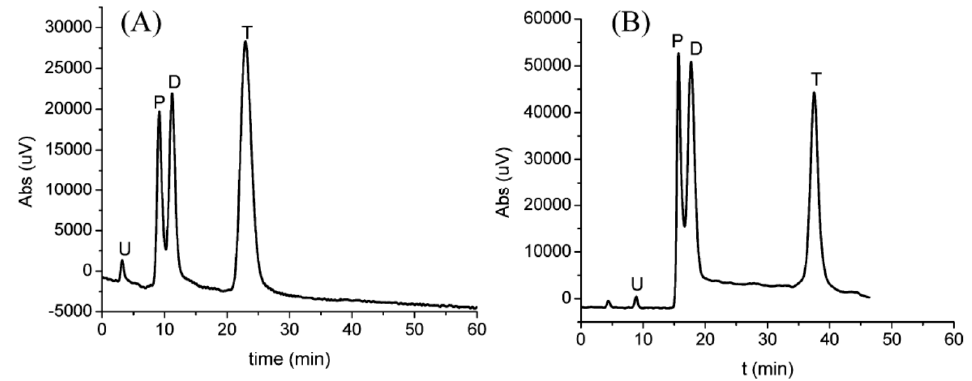
Figure 9. Effect of SWCNTs-coated monolithic column on the separation of a mixture containing phenol (P), toluene (T), uracil (U) and N , N -diethyl- m -toluamide (D) “Reproduced with permission from Y. Li et al. [49] Copyright American Chemical Society, 2005”. ( A ) Reference column; ( B ) SWCNTs-coated monolithic column.